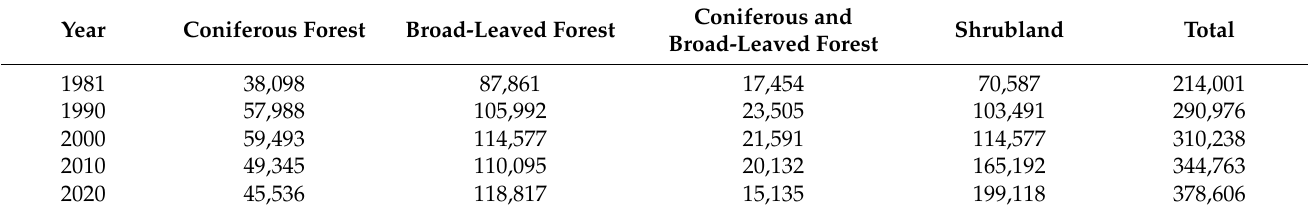
Table 4. Changes in the forest and shrubland area during 1981 and 2020 (km 2 ).